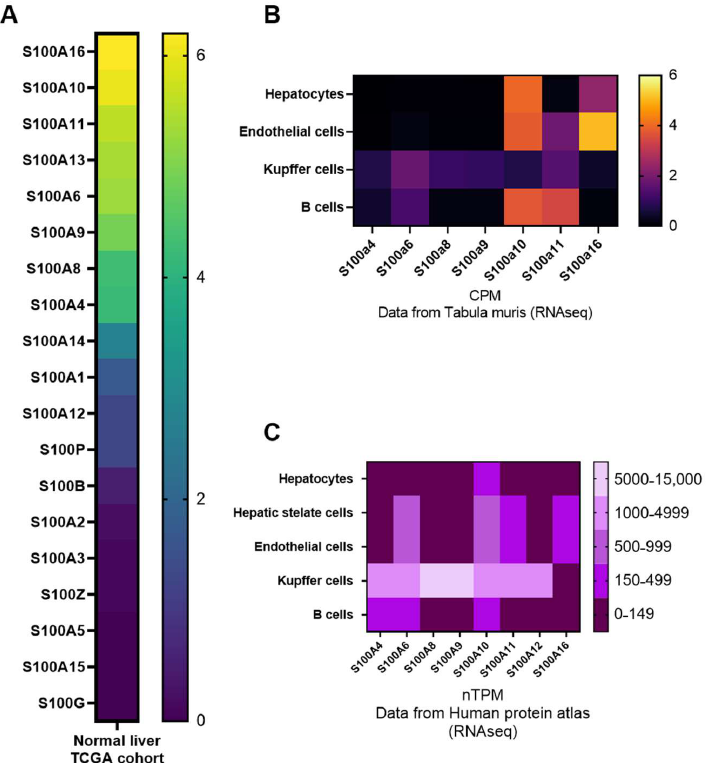
Figure 2. S100 mRNA expression in human liver tissues and human/mouse hepatic cells. ( A ) Relative mRNA expression (RNA seq analysis) of the different members of the S100 family in the TCGA cohort (normal human liver biopsies PMID: 25691825) acquired through the Gepia2 Cancer Database (http://gepia2.cancer-pku.cn/#index (accessed on 14 May 2022)). Values are expressed as log2(TPM + 1) (TPM—transcripts per million). ( B ) Relative mRNA expression (RNA seq analysis) of members of the S100 family (S100a4, S100a6, S100a8, S100a9, S100a10, S100a11 and S100a16) in 4 different cell types present in the livers of mice (hepatocytes, endothelial cells, Kupffer cells and B cells). Data were acquired through the tabula muris database (https://tabula-muris.ds.czbiohub.org/ (accessed on 14 May 2022)) and expression is presented as a heatmap of CPM (counts per million). ( C ) Relative mRNA expression (RNA seq analysis) of members of the S100 family (S100a4, S100a6, S100a8, S100a9, S100a10, S100a11, S100a12 and S100a16) in 5 different cell types present in the liver of humans (hepatocytes, hepatic stellate cells, endothelial cells, Kupffer cells and B cells). Data were acquired through the Human Protein Atlas database (https://www.proteinatlas.org/ (accessed on 14 May 2022)) and expression is presented as a heatmap of nTPM (transcripts per